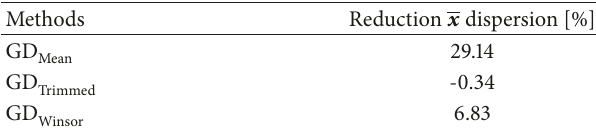
Table 47: Contaminated 𝜒 2 with 50 points.